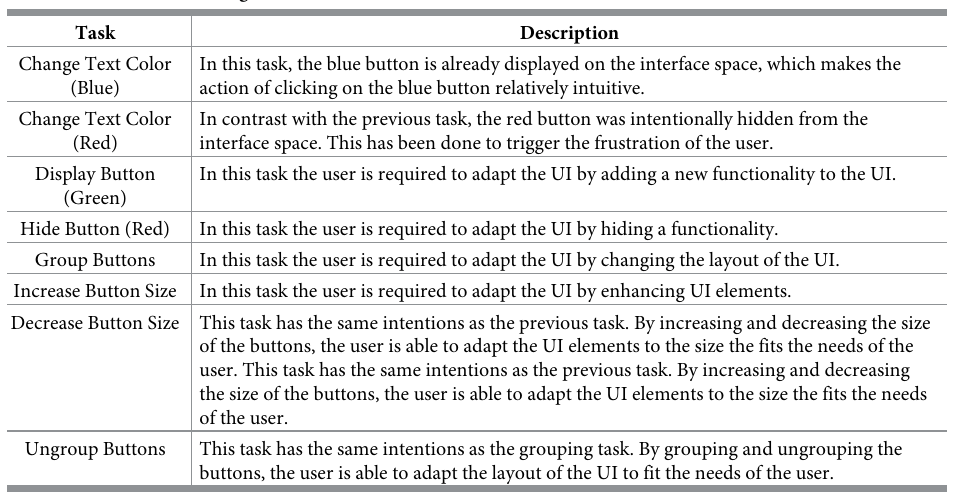
Table 2. Tasks for evaluating AUIs. Task Description Change Text Color